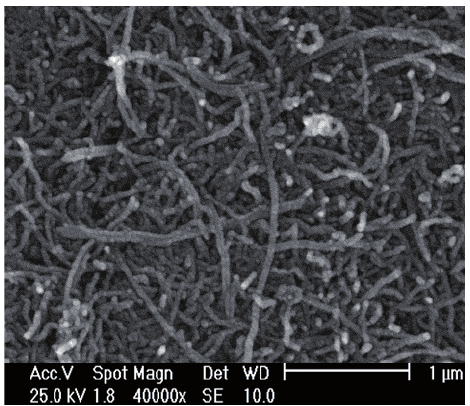
F 4: e calibration curve for Pb(II) ion, pH = 6.